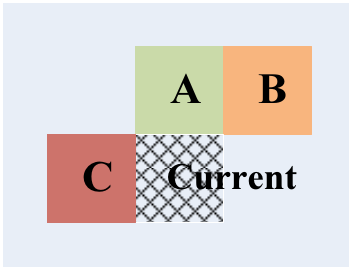
Figure 3. The spatial neighboring blocks of the current encoding block.